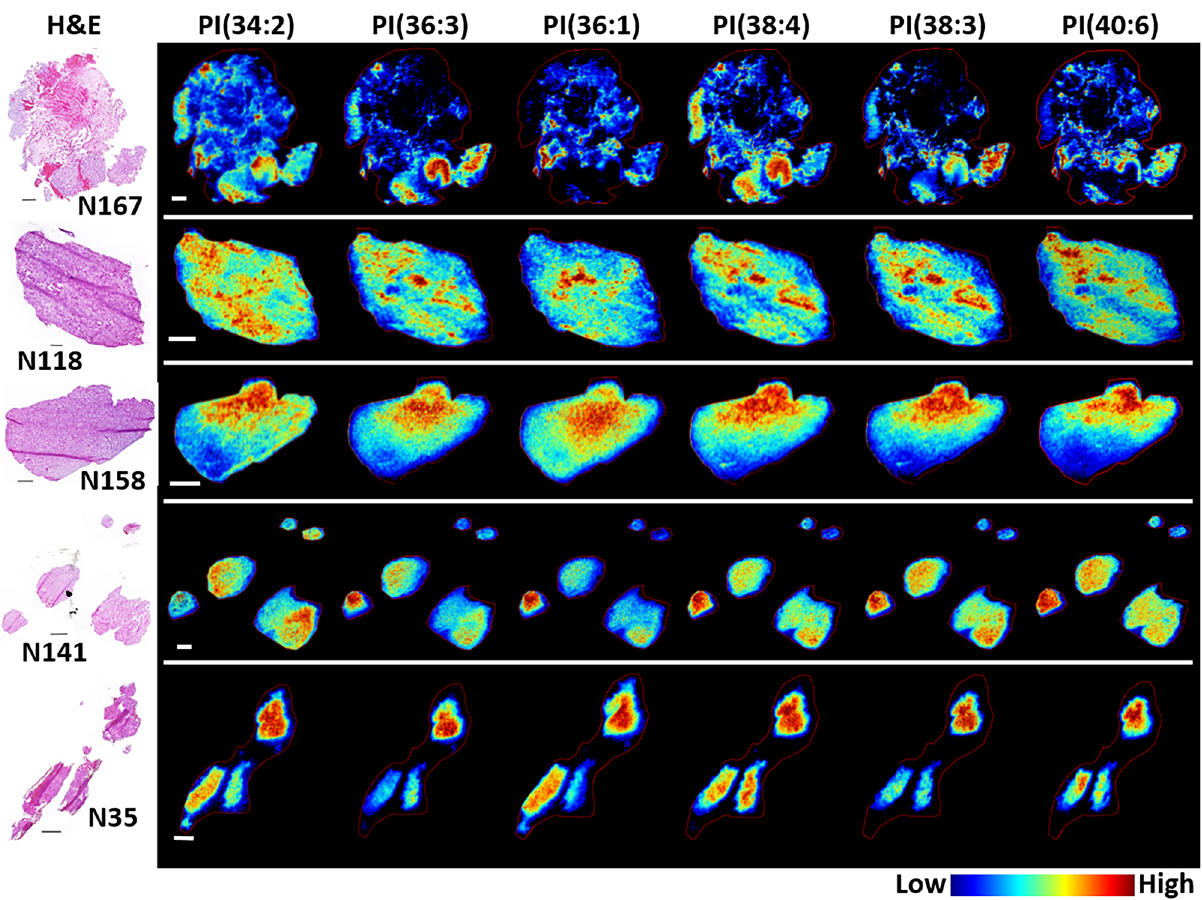
Figure 3. Representative MS images of several phosphatidylinositol (PI) species. PI(34:2), (36:3), (36:1), (38:4), (38:3) and (40:6) correspond to m/z 833.521, 859.535, 863.564, 885.550, 887.562 and 909.552, respectively. Images were acquired at 30 µm pixel resolution from 5 µm thick sections; the H&E stained section of each sample is shown in the left panel. Scale bars are 1 (40:6) to one another. For example, PI(38:4) was highly localized to the moderately dense tumor cell regions near the bottom, whereas PI(38:3) was most abundant in the bottom right region consisting of higher tumor cell den- sity, pseudopalisading tumor cells, and MVP. The distribution and accumulation of PIs in sample N118 demon- strated similar trends to those observed for CLs, in that relatively high signal intensity was detected throughout the tumor cell regions, with the highest signals differentially distributed across distinct pathological regions of MVPs. A gradient in the signal intensity detected for all PI lipid species was again evident in sample N158 that correlated with low-to-high tumor cell density. In samples N141 and N35, PI species were detected with different abundances in each biopsy sample. Unlike CLs, however, PIs were detected with high signal intensity in sample N141. These were predominant in the two larger biopsy samples and localized to areas that contained MVPs. In sample N35, PIs demonstrated a more homogeneous distribution within each biopsy sample with the highest signal intensity detected throughout the top biopsy section, which contained a large acellular fluid filled region and vascular clusters. A complete description of all PIs detected and their histology-based distribution in all five samples is presented in Supplementary Table S2. PIs play central roles in cell signaling and regulation that is dictated by both the composition of their fatty acid residues and phosphorylation at the 3’, 4’ and 5’ position of their inositol head group, which gives rise to the second messengers, phosphatidylinositol phosphates (PIPs) 40 . The enzymes involved in the regulation of PIPs and thus PIP signaling are some of the most well-known and studied in cancer 41 . Phosphoinositide-3-kinase (PI3K), produces PIP3, which activates the AKT and the mammalian target of rapamycin (mTOR) signaling pathways 42 . The PI3K/AKT/mTOR pathway is upregulated in most human cancers and drives cell survival, pro- liferation and invasion 41,42 . Conversely, phosphatase and tensin homolog (PTEN), the enzyme responsible for dephosphorylation of PIP3 and known as a tumor suppressor, is silenced in many human cancers 41 . The impact of PI fatty acid composition in regulation of these pathways during glioblastoma development and progression is unknown. Recent studies, however, have shown that alterations to PI fatty acyl chain composition altered AKT localization and downstream signaling in a prostate cancer model 43 . Fatty acyl chain remodeling of PIs was also shown during the analysis of primary breast cancer tissue 44 . This study identified PI(38:3) as a hallmark of inva- sive cancer cells that was associated with higher incidence of lymph node metastasis 44 . In the current study, this